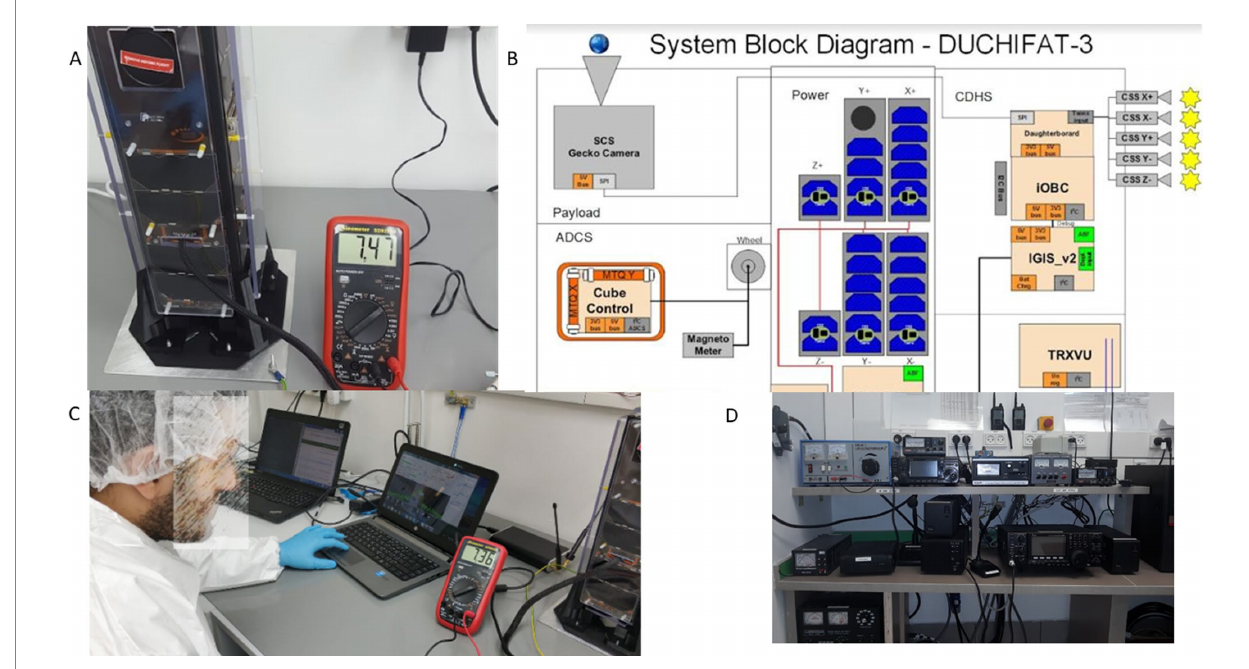
FIGURE 1 The Duchifat 3 CubeSat during initial tests, the ground station and a diagram representing the satellite’s